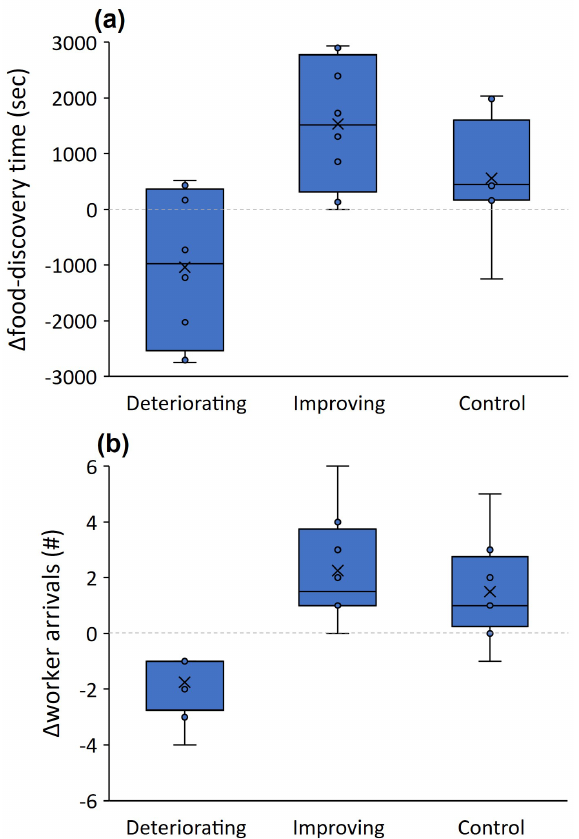
Figure 5. ∆ food-discovery time (food-discovery time in the first run minus that in the third run) ( a ) and ∆ worker arrivals (the number of workers arriving at the food reward in the third run minus that in the first run) ( b ) when conditions deteriorated (pits are deployed only in the third run), when they improved (pits were deployed only in the first and second run), vs. the control (no pits, taken from the first experiment). Lines and × signs in the box centers stand for the median and mean. Boxes and error bars stand for the quartiles and the range.